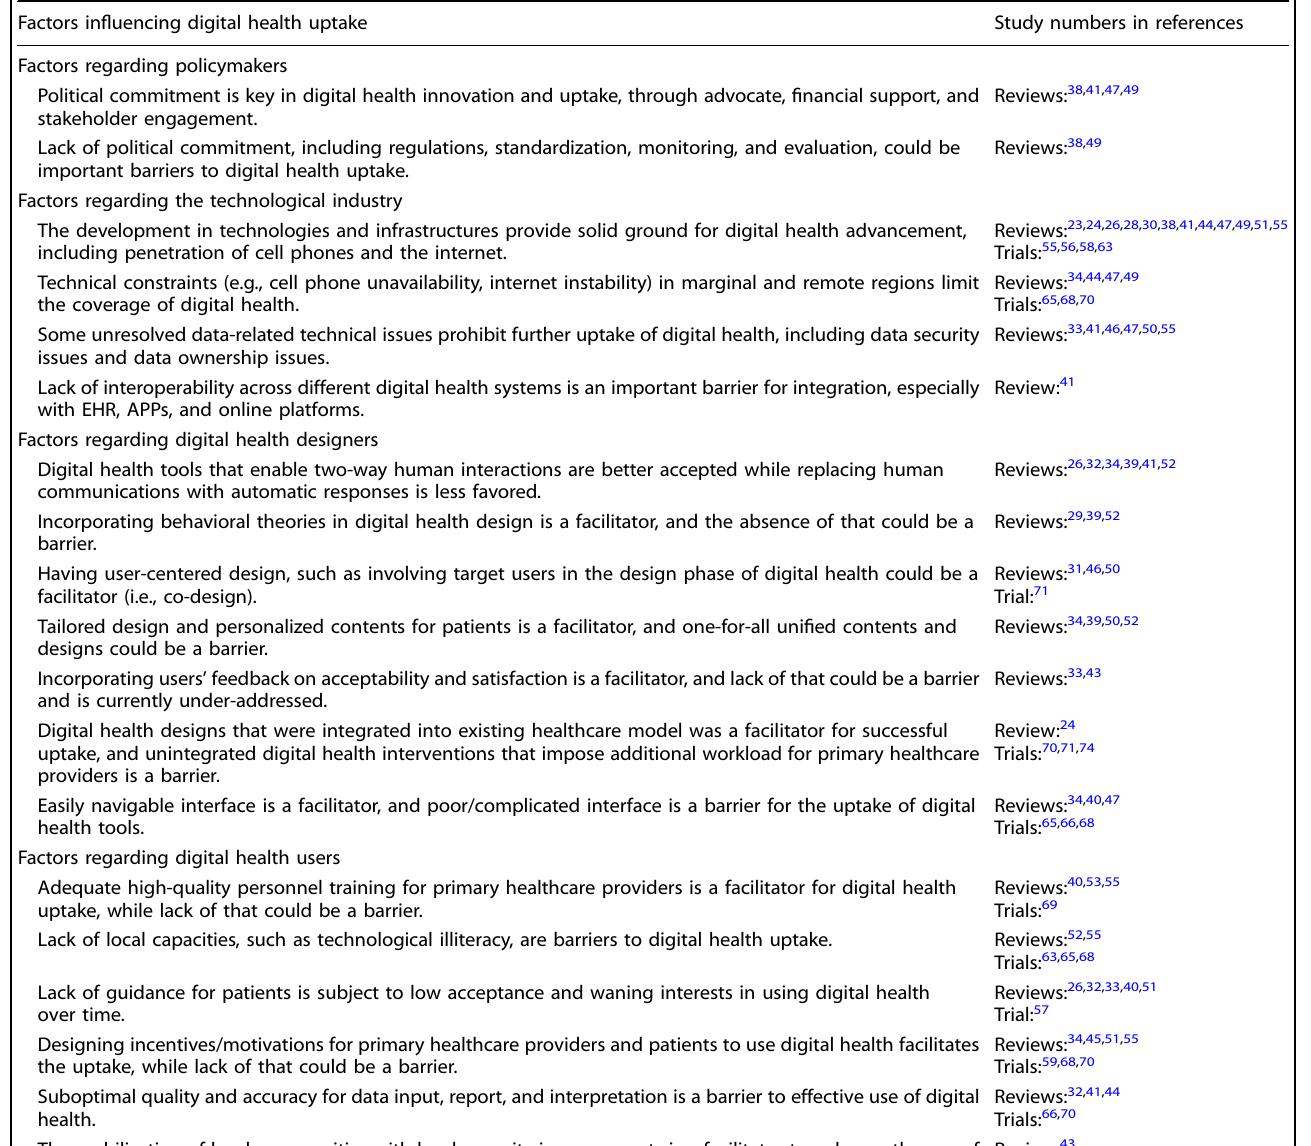
Table 2. Factors in fl uencing real-world uptake of digital health interventions for non-communicable disease management in primary health care. Factors in fl uencing digital health